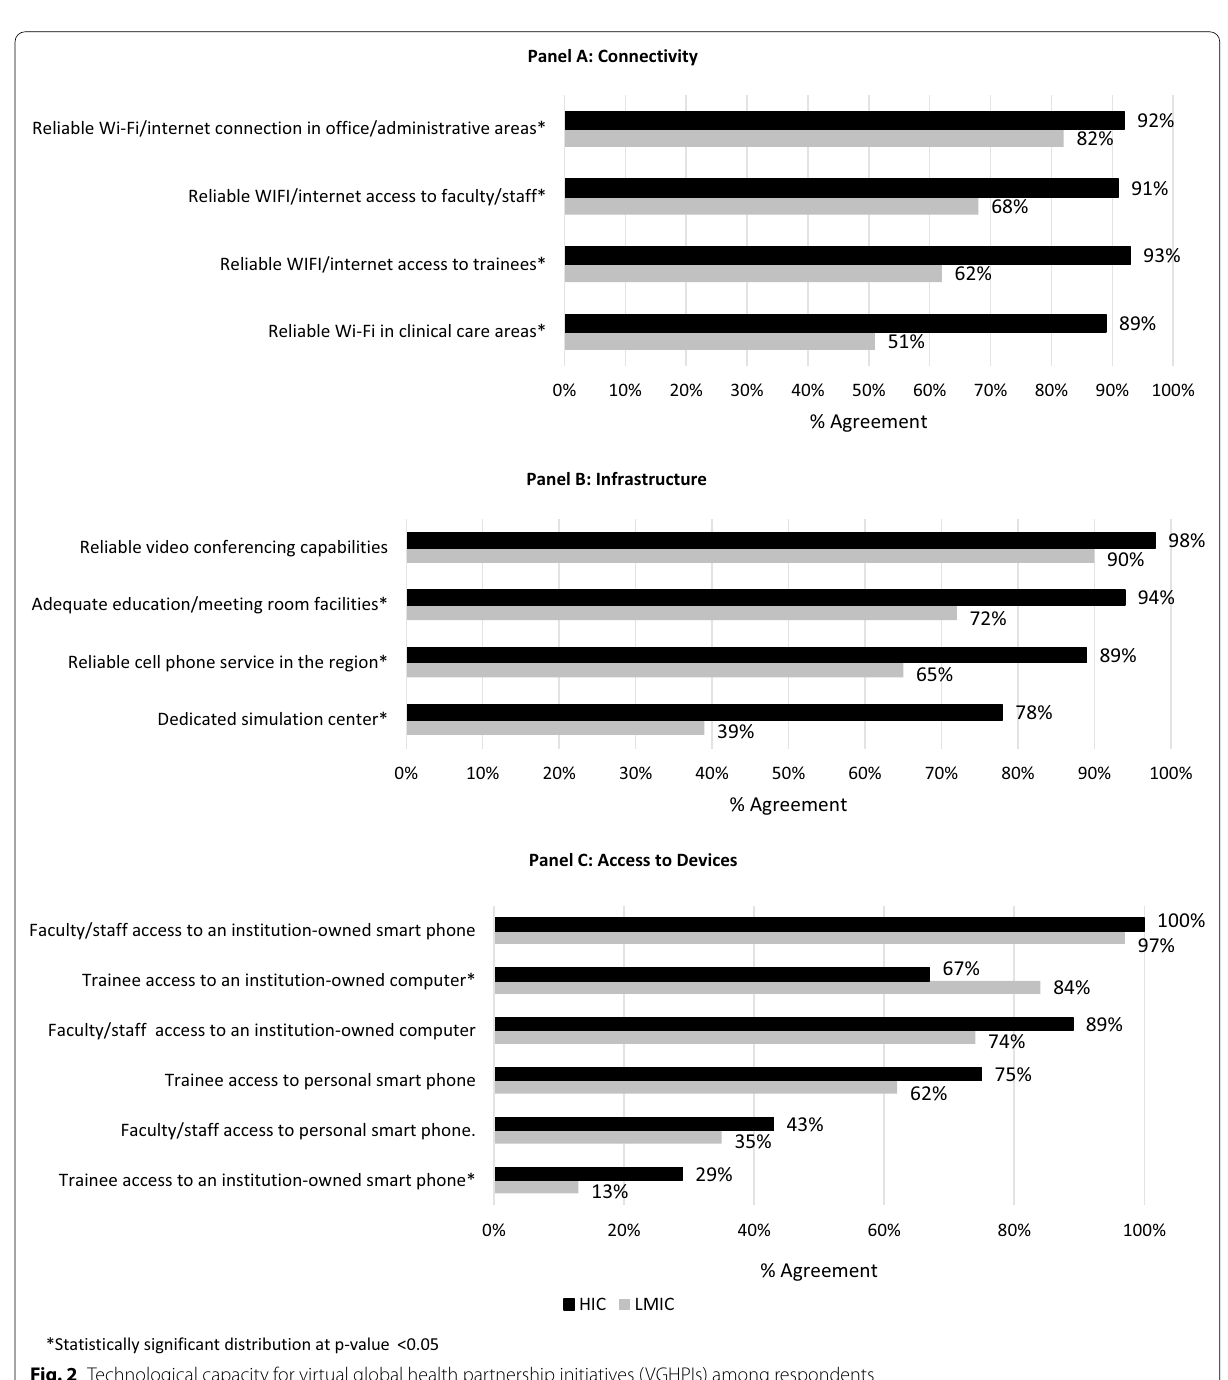
Fig. 2 Technological capacity for virtual global health partnership initiatives (VGHPIs) among